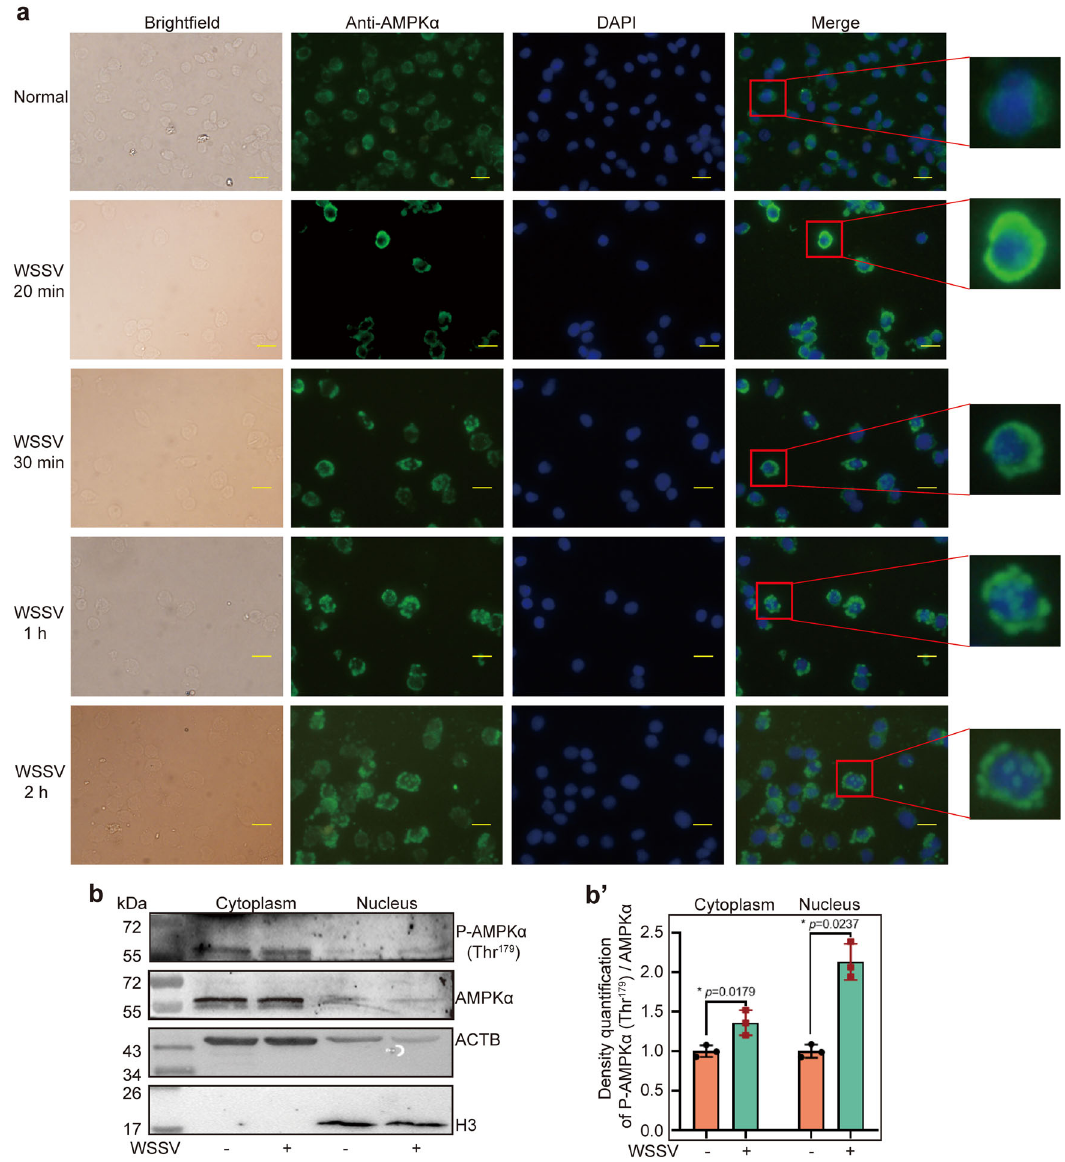
Fig. 5 AMPK is translocated into the nucleus partially in hemocytes and intestine of shrimp challenged by WSSV. a The nuclear translocation of AMPK in hemocytes was detected at 0, 20 min, 30 min, 1 h, and 2 h post WSSV challenge using a fl uorescent immunocytochemical assay. Scale bar = 10 μ m. b Nuclear translocation of AMPK α in the intestines analyzed using western blotting, b ′ The statistical analysis of panel b based on three